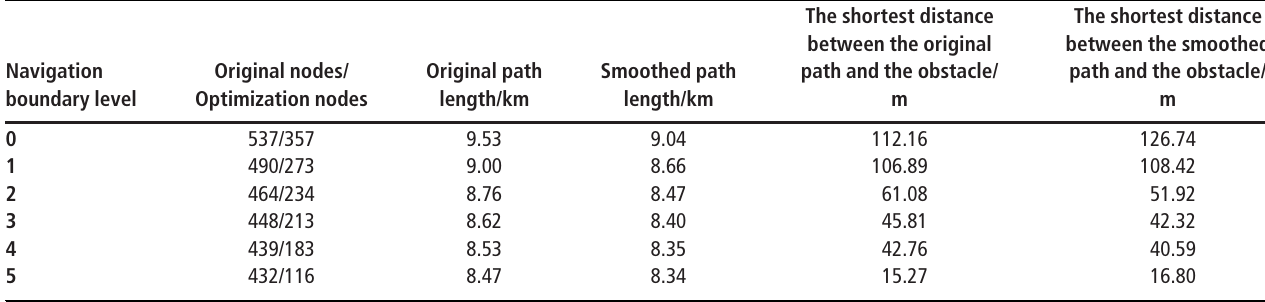
Table 2 Comparison of optimization results under different navigation boundaries